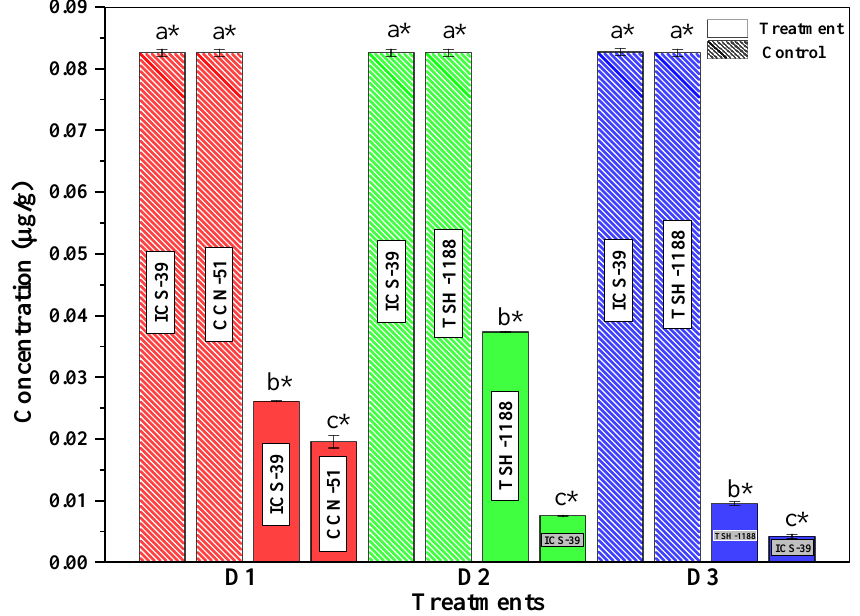
Figure 11. Different concentrations of Ni present in the aerial part of the seedling in the presence of zeolite 5A compared to its counterpart contaminated only with Ni. It can be observed that there is a significant difference within the variable’s shrinkage and genotypes. * p < 0.05. a, b, c, and d denote the groups that had statistical significance among themselves, within each treatment.